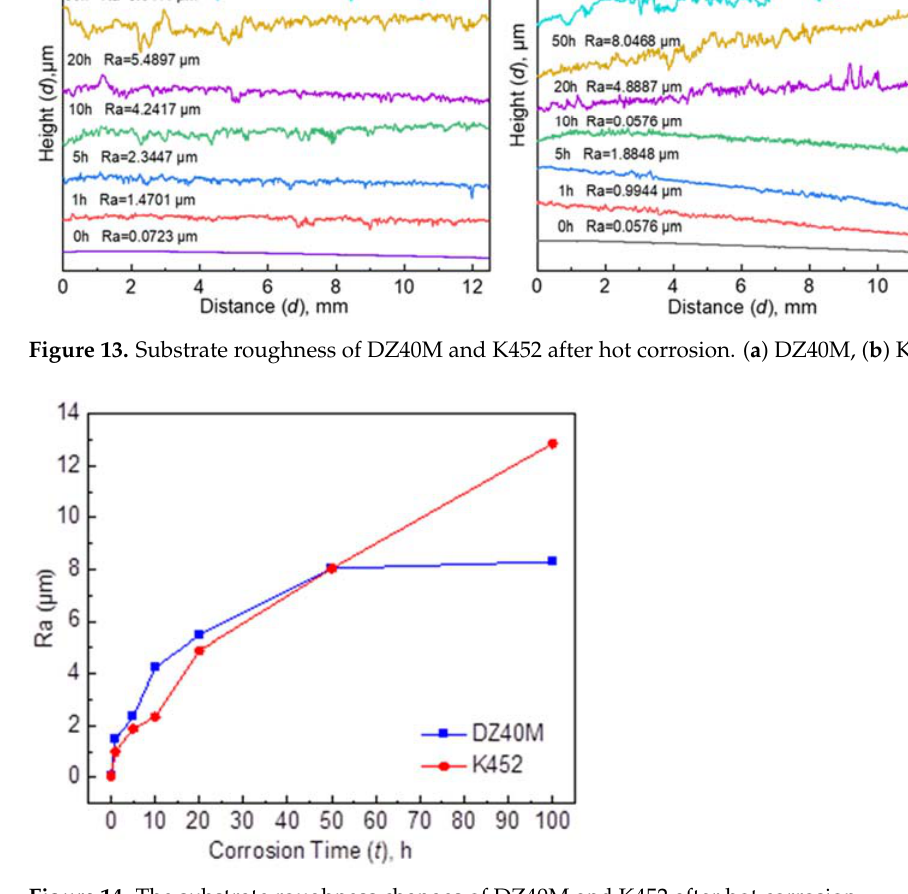
Figure 14. The substrate roughness changes of DZ40M and K452 after hot corrosion.